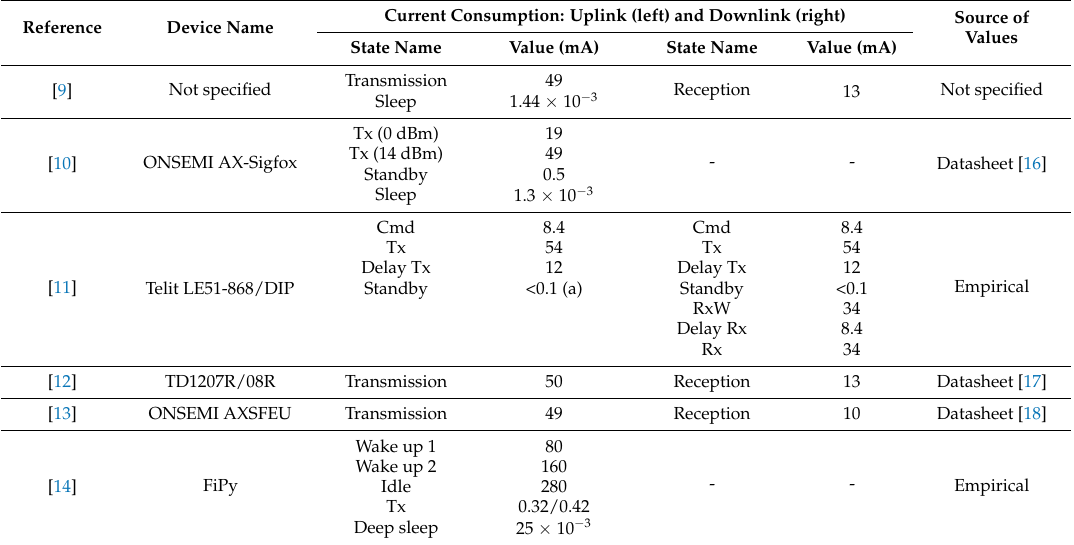
Table 1. Current consumption of Sigfox devices considered in the literature. For each referenced paper, the device and the current consumption states (names and values) are shown, indicating their source. The work by Mart í nez et al. is not included because current consumption states are not identified and their related values are not provided in that work